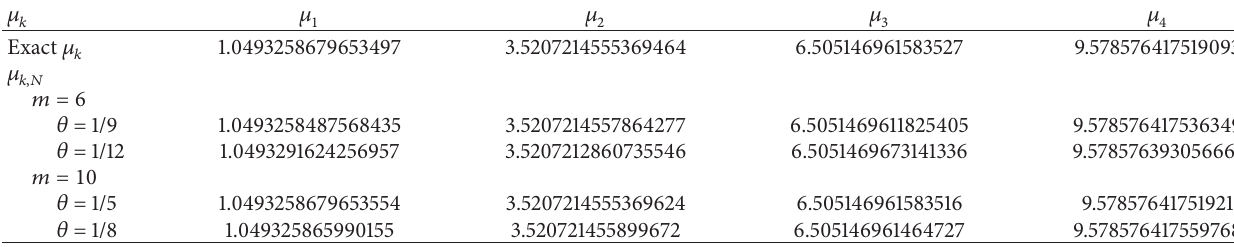
Table 2: Absolute error |𝜇 𝑘 − 𝜇 𝑘,𝑁 | .